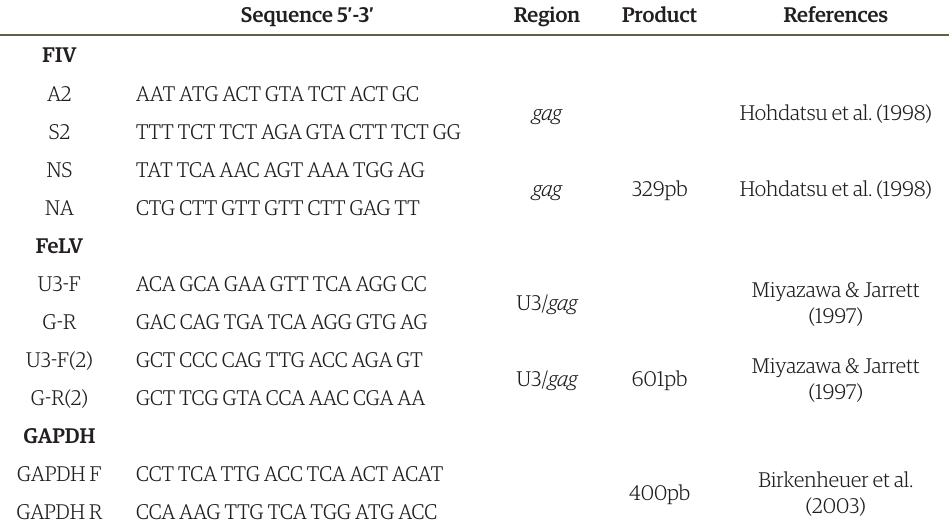
Table 1. Primers used in nested-PCR for FIV and FeLV, and GAPDH . Oligonucleotide sequence, gene and amplified product